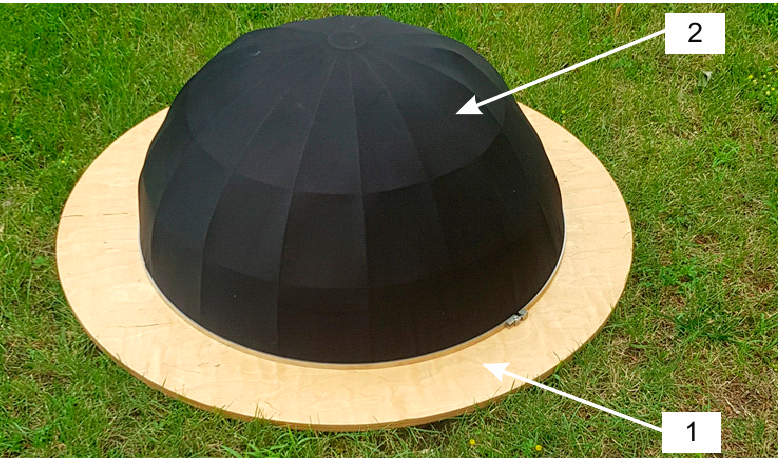
Figure 5. Image of external windscreen (2) installed on the reflecting board (1).